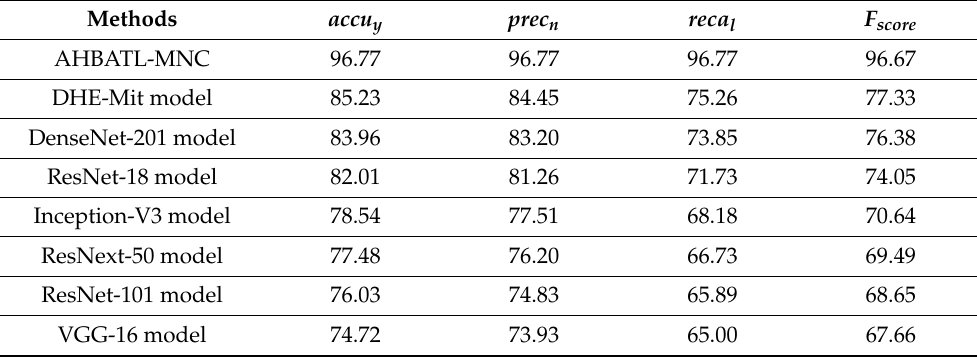
Table 4. Comparative analysis of AHBATL-MNC system with other